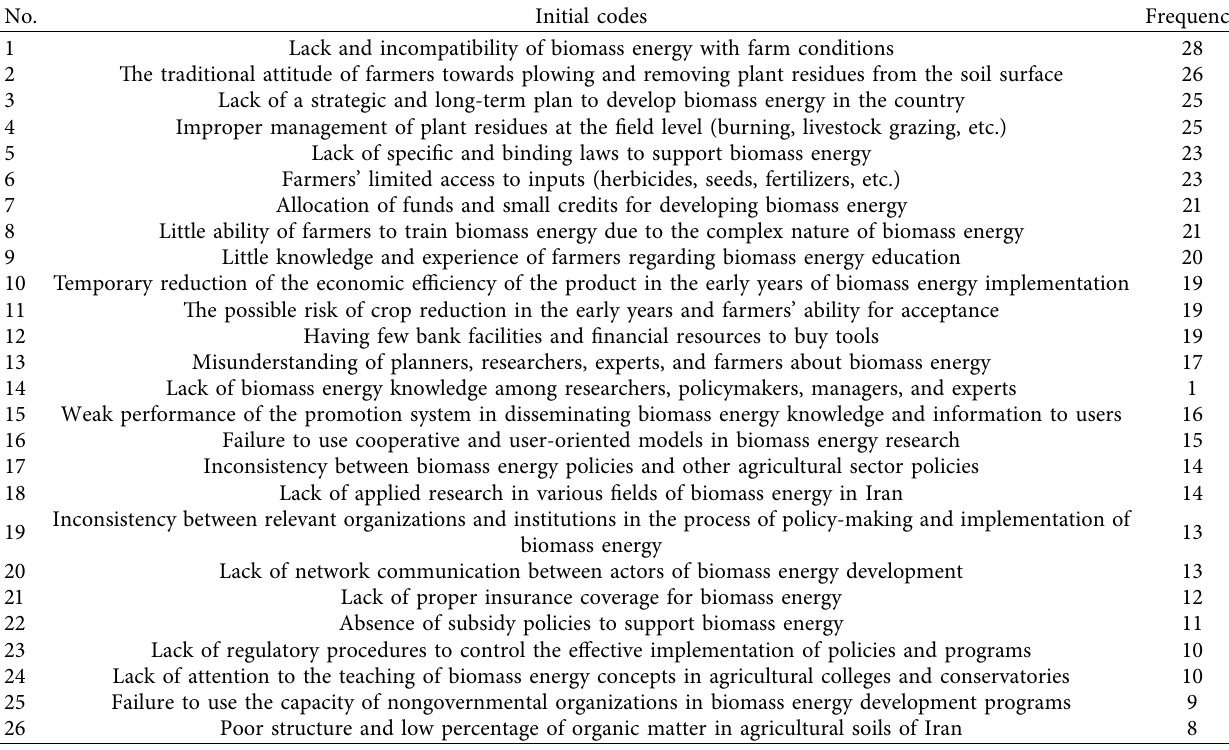
Table 2: Initial codes resulting from qualitative data content analysis (policy training for biomass energy development in agriculture). No. Initial codes